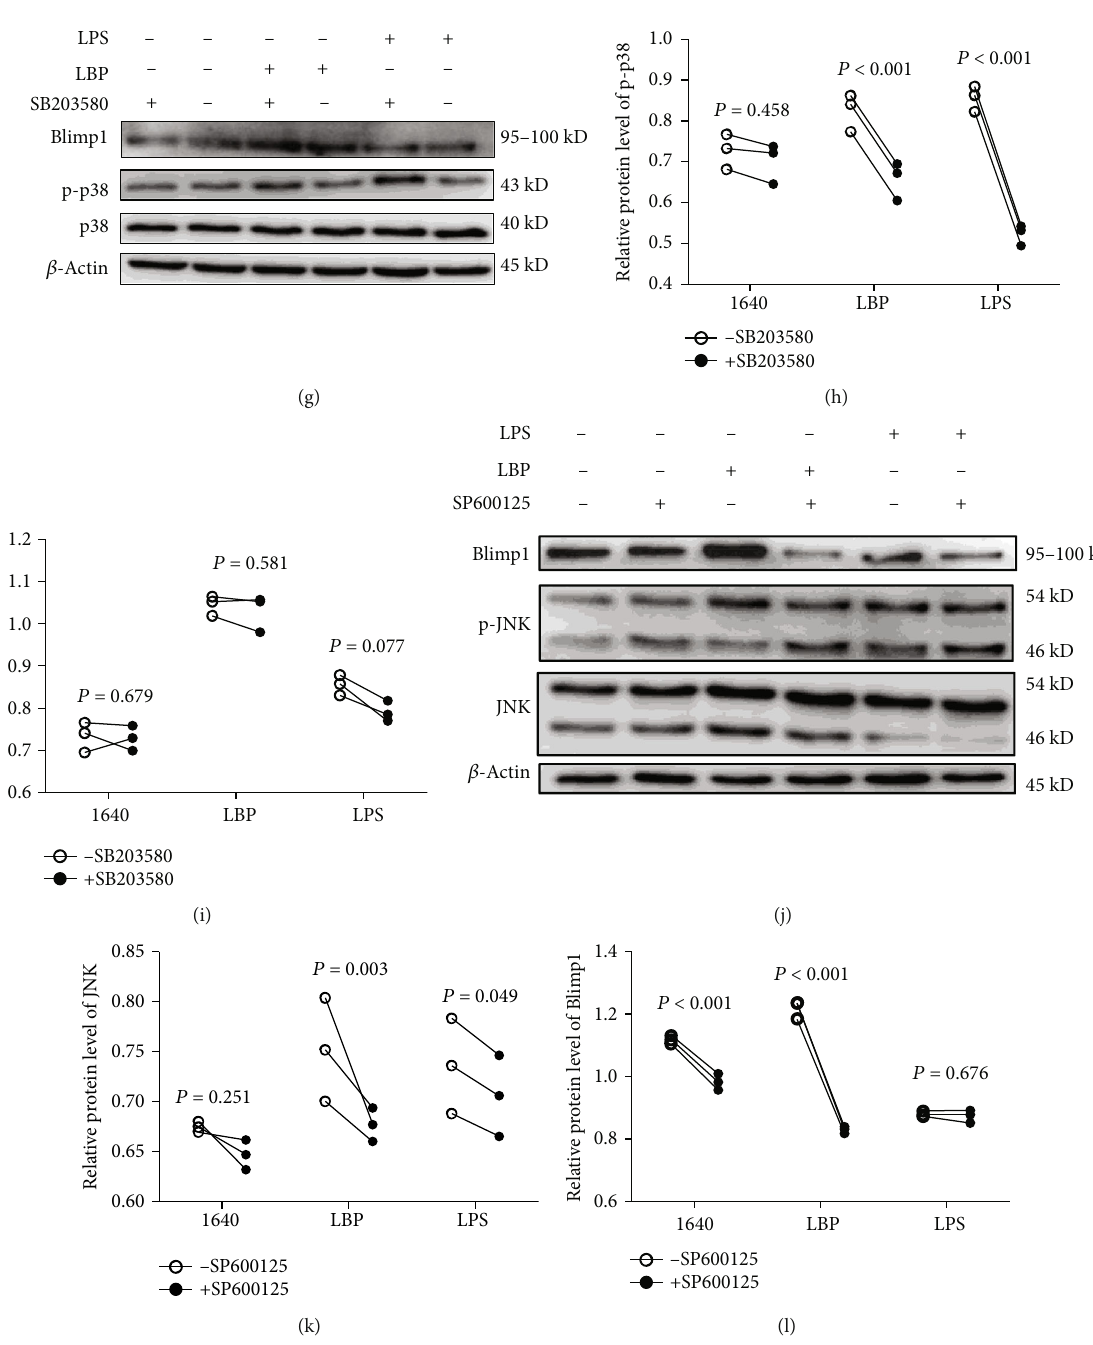
Figure 5: LBP regulate DCs via TLR4-MAPK-Blimp1. DCs were pretreated with 10 μ M PD98059, 5 μ M SB203580, and 50 μ M SP600125 for 1h, respectively, and then treated with 100 ng/mL LPS or 200 μ g/mL LBP for 30 min. The mRNA and protein expression of Erk1/2 (a, b, and e), Blimp1 (c and f), p38 (h), Blimp1 (i), JNK (k), and Blimp1 (l) was analyzed by Taqman-PCR and Western blot. Values are the mean and SD of 3 independent experiments. ∗ P < 0 : 05 , ∗∗ P < 0 : 01 , and ∗∗∗ P < 0 : 001